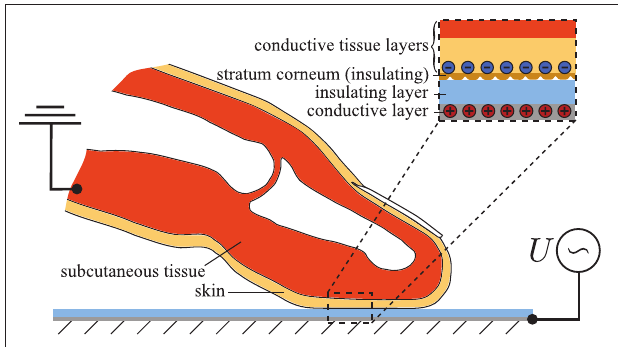
FIGURE 1 | Schematic representation of the electromechanical frictional contact between the index fingertip and